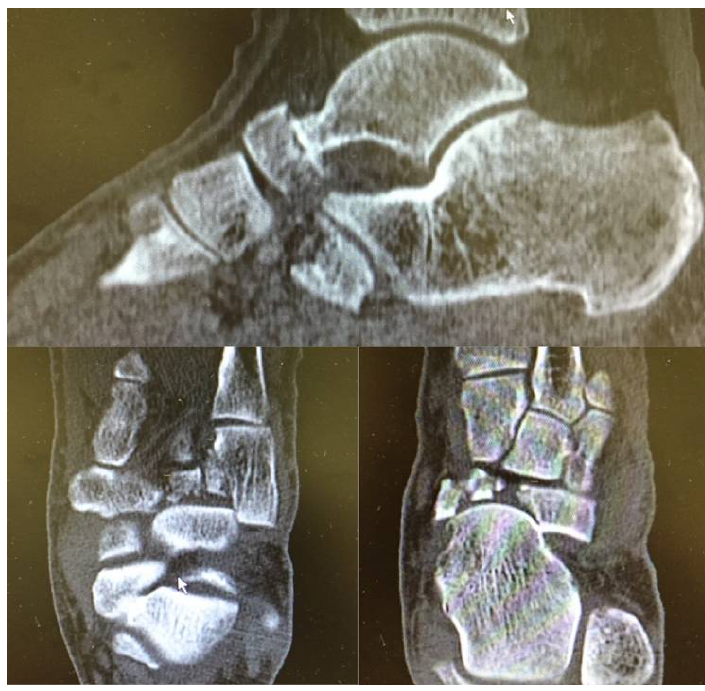
Figure 2. Preoperative